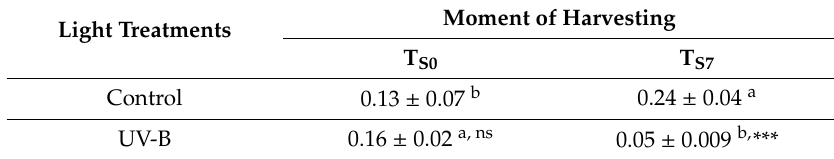
Table 1. Antioxidant activity (EC 50 values in g L − 1 ) of leaf extracts of O. basilicum at the end of the light treatment (T S0 ) and after seven days of storage (T S7 ) from plants cultivated under control (white light) and supplemental UV-B radiation.